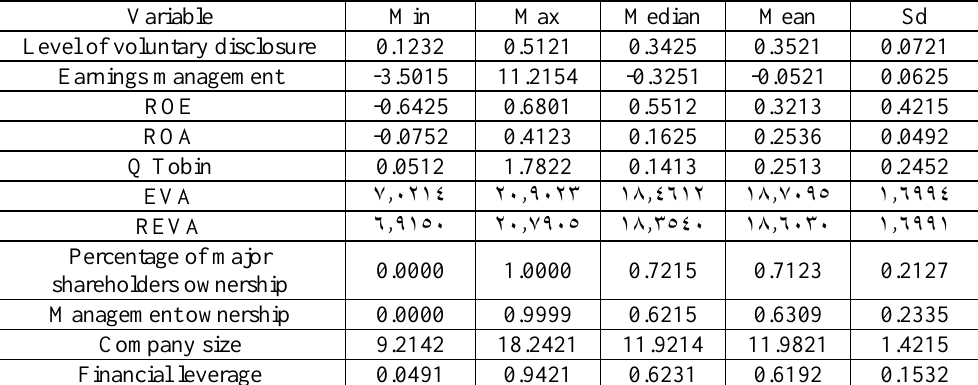
Table 2. Statistical indicators related to the research